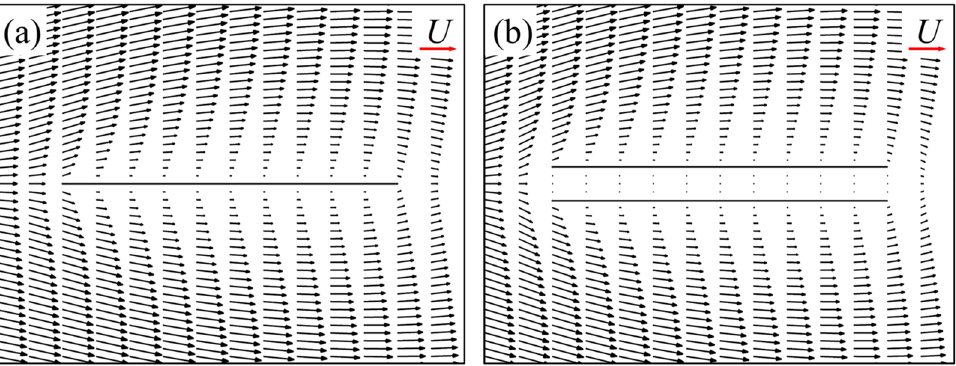
Figure 5. The plot of non-dimensional velocity vector around ( a ) a single flat-plate wing and ( b ) two flat-plate wings.